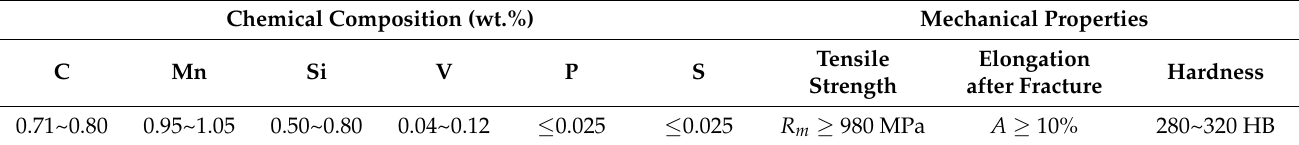
Table 1. Chemical composition and mechanical properties of U75V rail steel. Chemical Composition